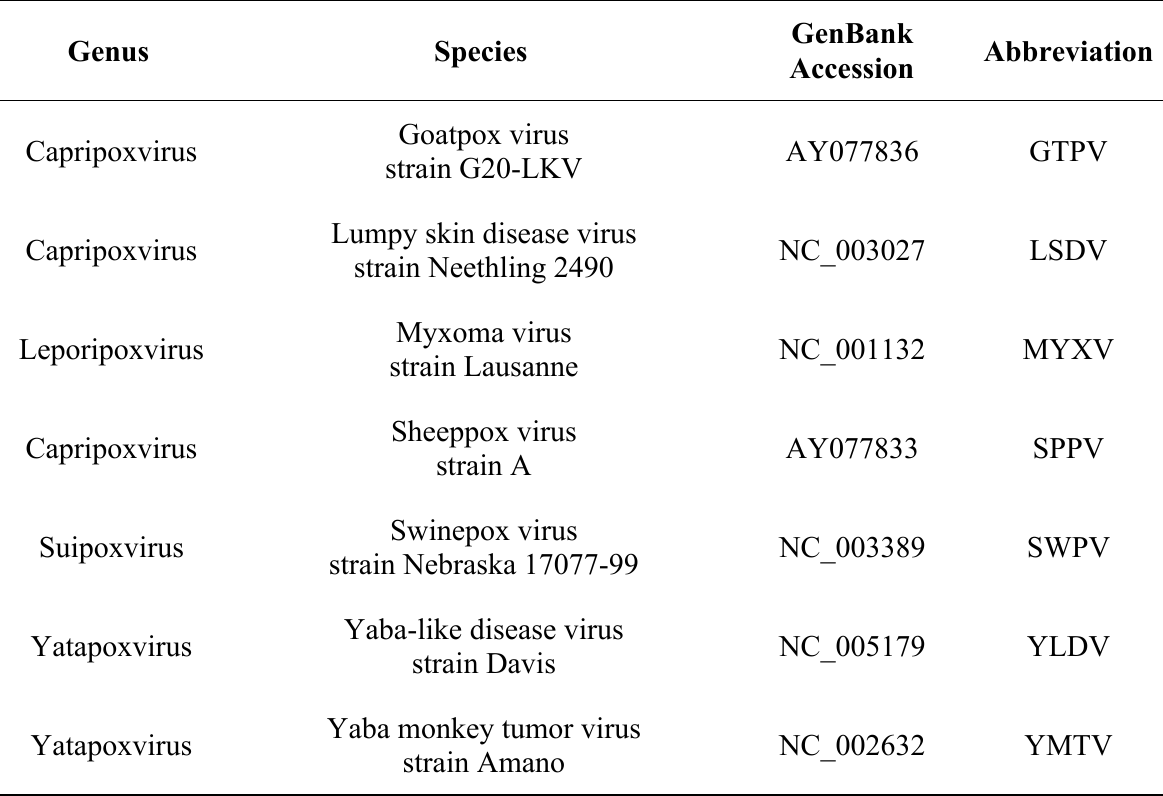
Table 1. The seven genomes from the poxvirus subfamily Chordopoxvirinae used in this